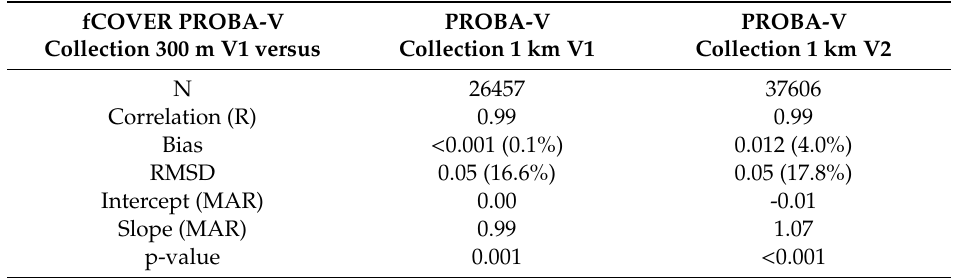
Table 6. fCOVER PROBA-V Collection 300 m V1 versus reference validation metrics computed over all LANDVAL sites for the 2016–2017 period. Relative values (%) are shown in brackets.